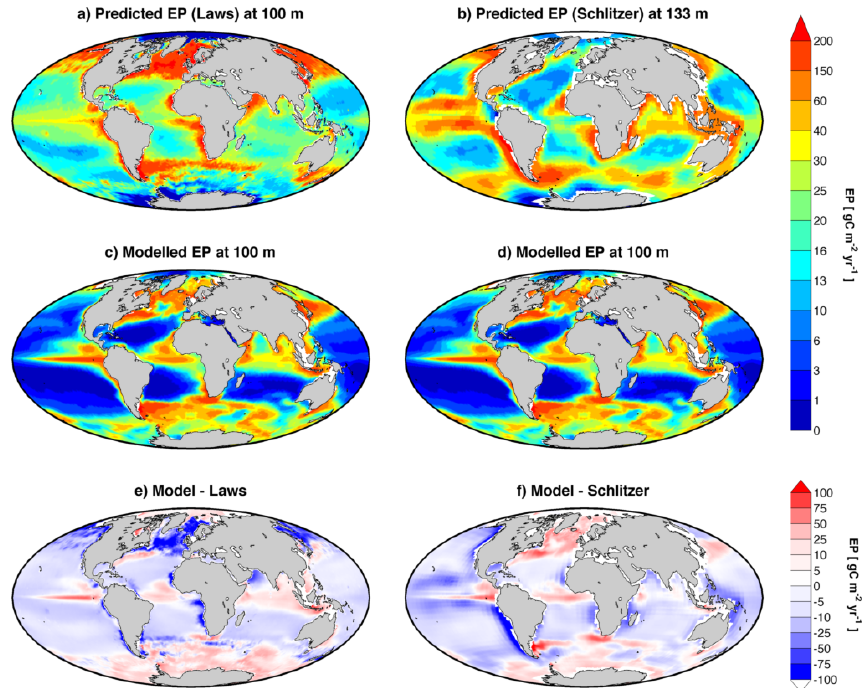
Figure 14. Spatial distribution of export of particulate organic matter plotted to the scale used by Moore et al. (2004). (a) Laws. (b) Schlitzer. (c) and (d) modelled (same figure). (e) Residual: modelled − Laws. (f) Residual: modelled − Schlitzer.